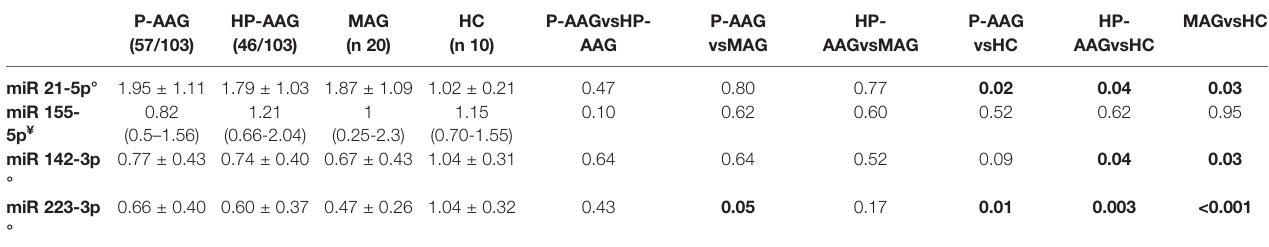
TABLE 2 | miRNA expression in our study